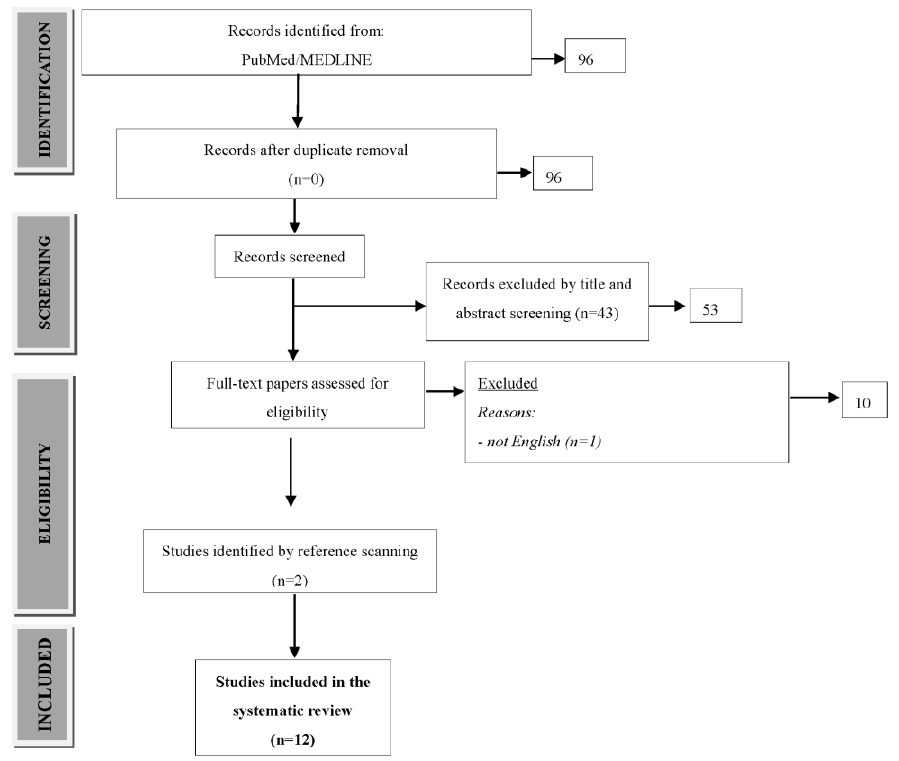
Figure 1. Study flow diagram.